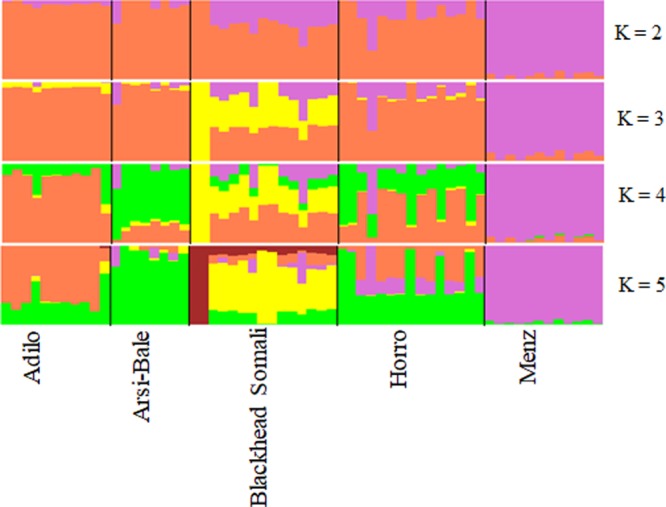
Bayesian-based clustering of five Ethiopian sheep populations based on an analysis of 80,602 SNPs.